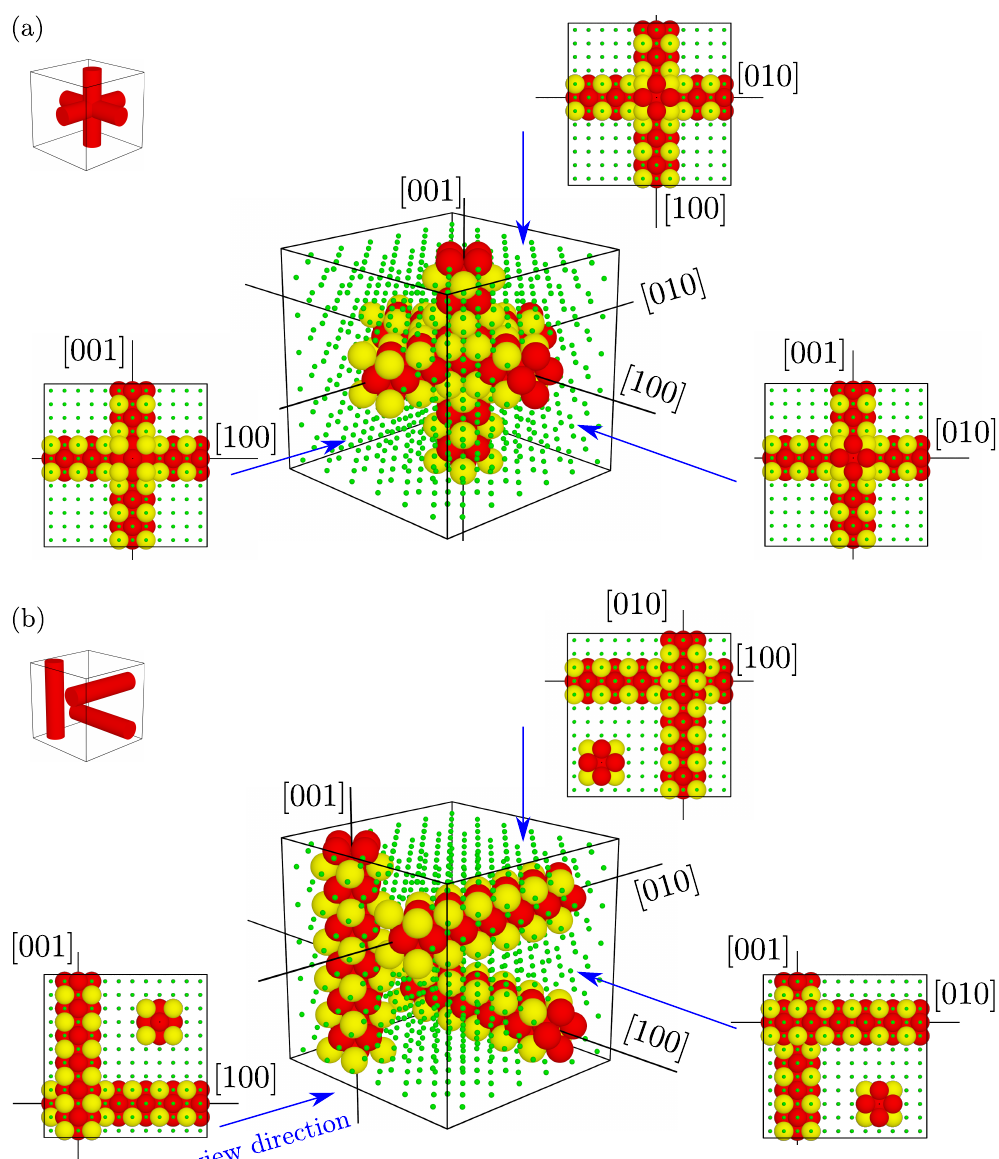
Figure 2. Illustration of the two different channel layouts ( a ) crossing nanochannels and ( b ) separate nanochannels. The included inserts present projections from the indicated directions for a precise presentation of the channel layouts. The yellow color has been used only to highlight the differences between the D -type and S -type channels. The green dots represent the matrix spheres located outside the